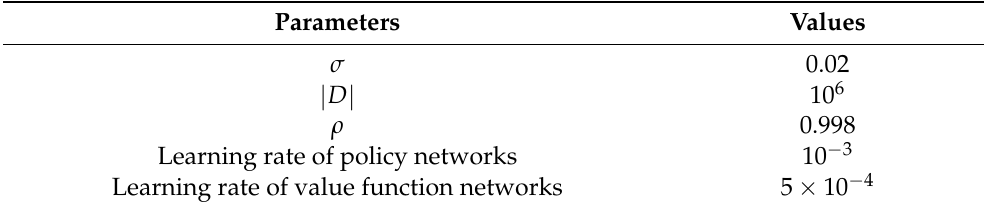
Table 2. Parameter settings of DDPG.